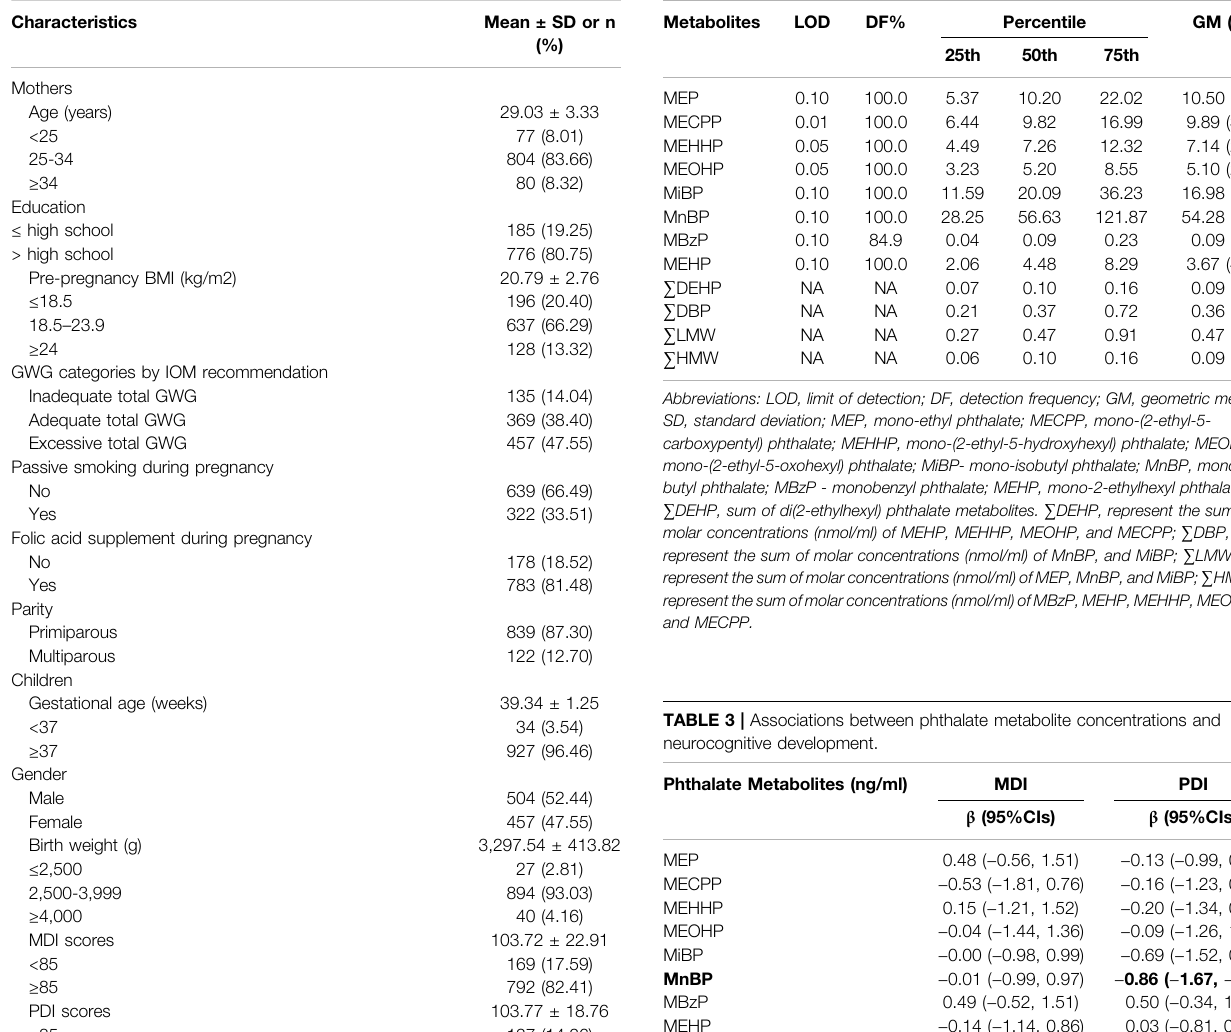
TABLE 1 | General characteristics of the participants (n = 961). TABLE 2 | Distributions of urinary phthalate metabolite concentrations (ng/ml).